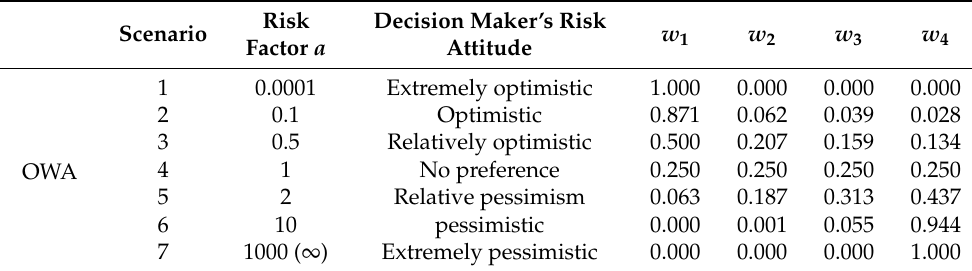
Table 2. Order layer weight under multiple scenarios.